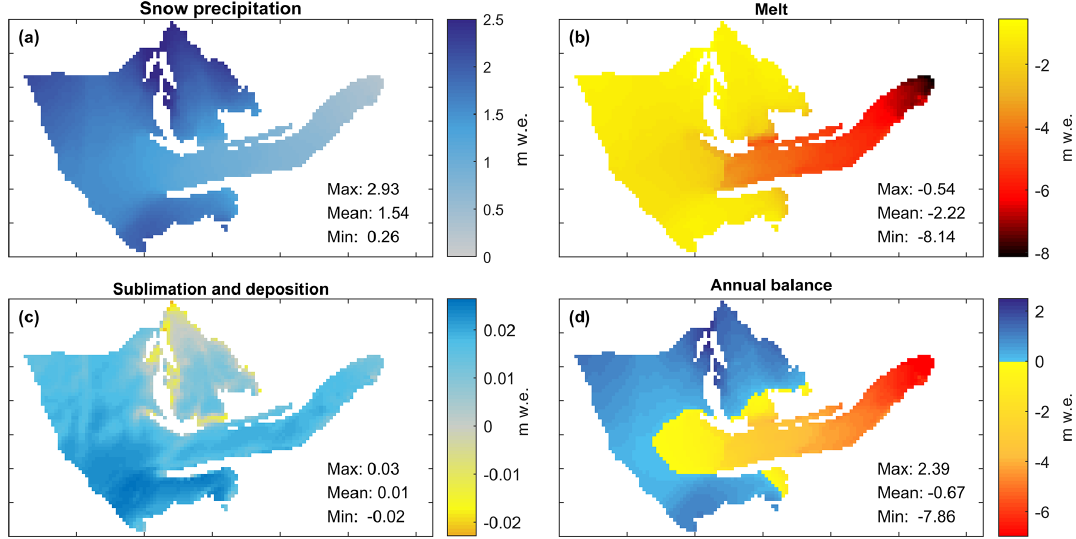
Figure 11. Simulated average spatial patterns of reference annual mass balance ( B a 2016. (a) Snow accumulation; (b) melt; (c) sublimation and deposition; (d) annual balance. The accumulation zone on (d) is delineated by the positive blue colour scale; the ablation zone is delineated by the negative yellow–red